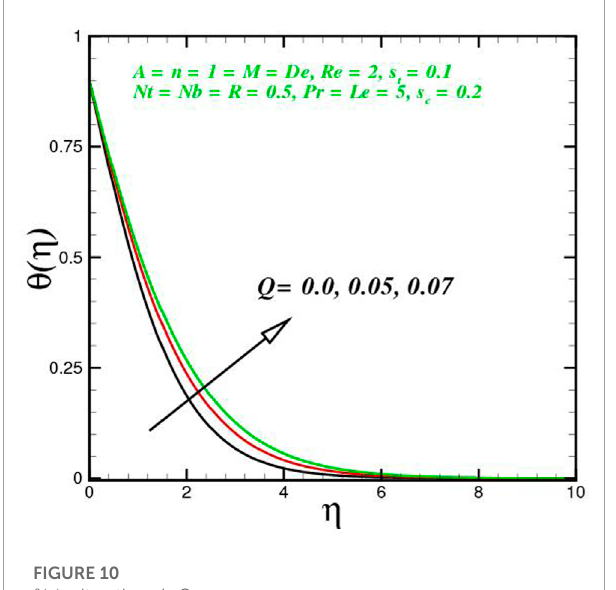
FIGURE 12 ϕ ( η ) , alteration via Q.